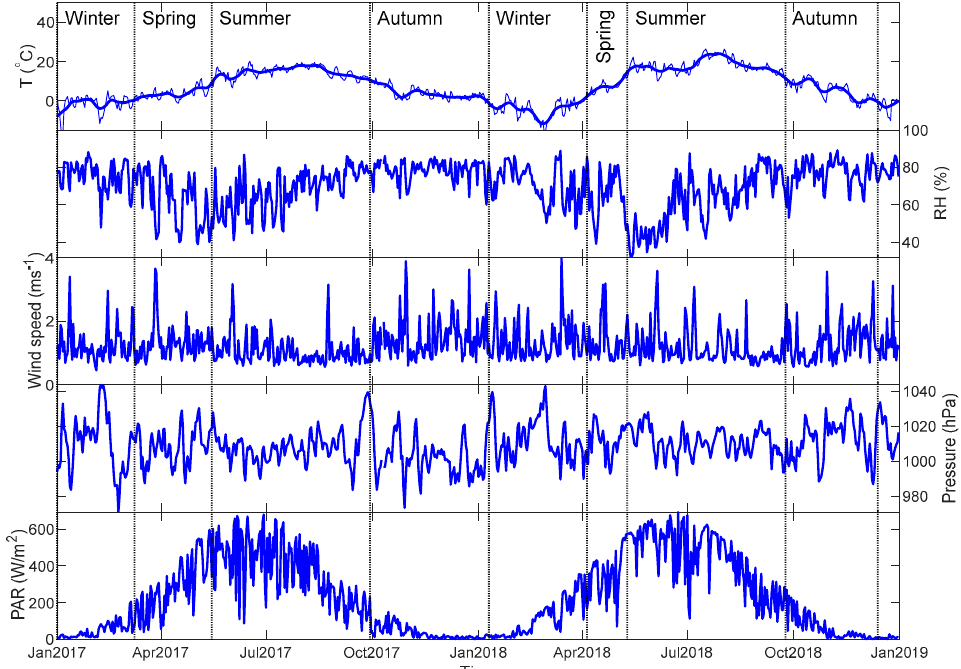
Figure 3. Meteorological data during the measurement period. Daily temperature ( ◦ C), relative humidity (%), wind speed (m s − 1 ), pressure (hPa) and PAR (W m − 2 ) are shown from the top panel to the bottom. A smoothing curve with lowess filter is also plotted on top of the daily temperature to identify the seasons based on thermal definition. Vertical lines clarify the separation of seasons.